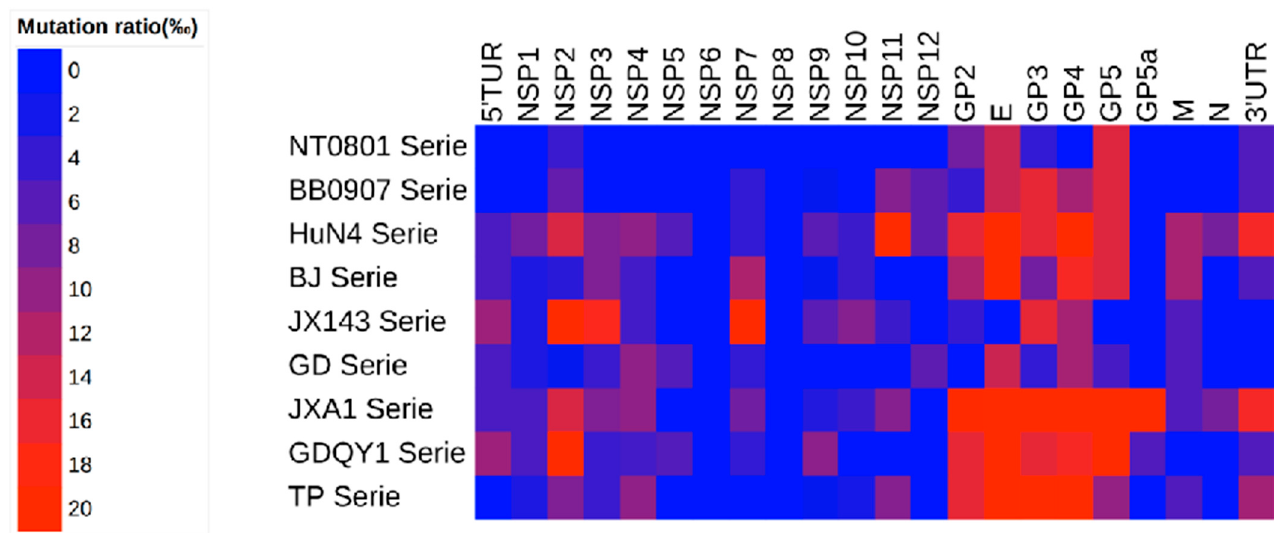
Figure 6. Heat map of mutation during PRRSV attenuation in vitro of each